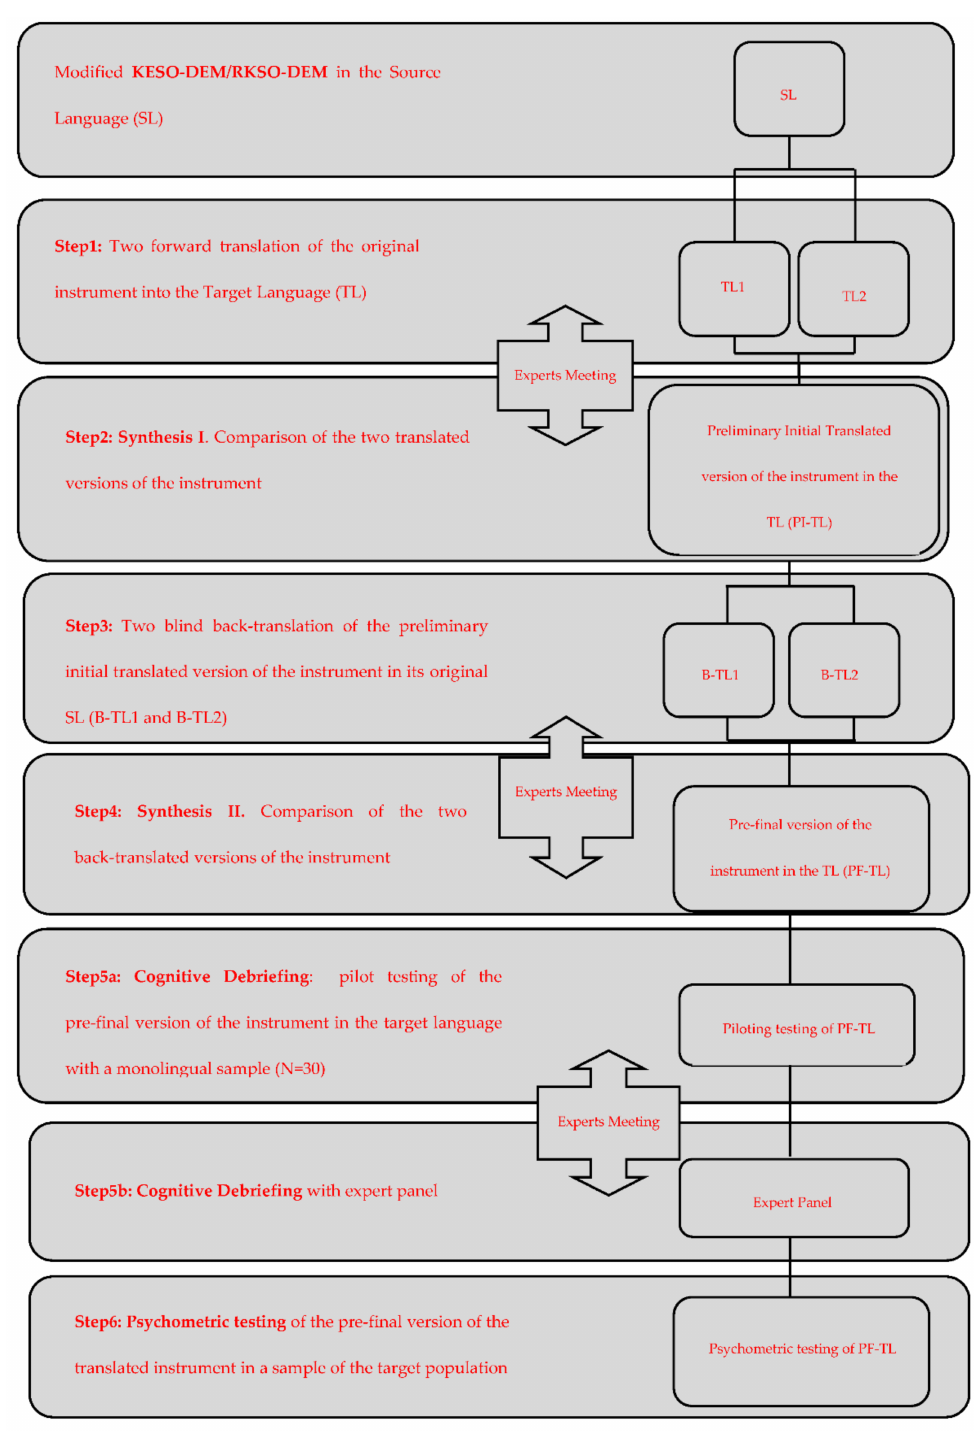
Figure 1. Translation, adaptation, and content validity process of the Spanish version of the KESO- DEM/RKSO-DEM